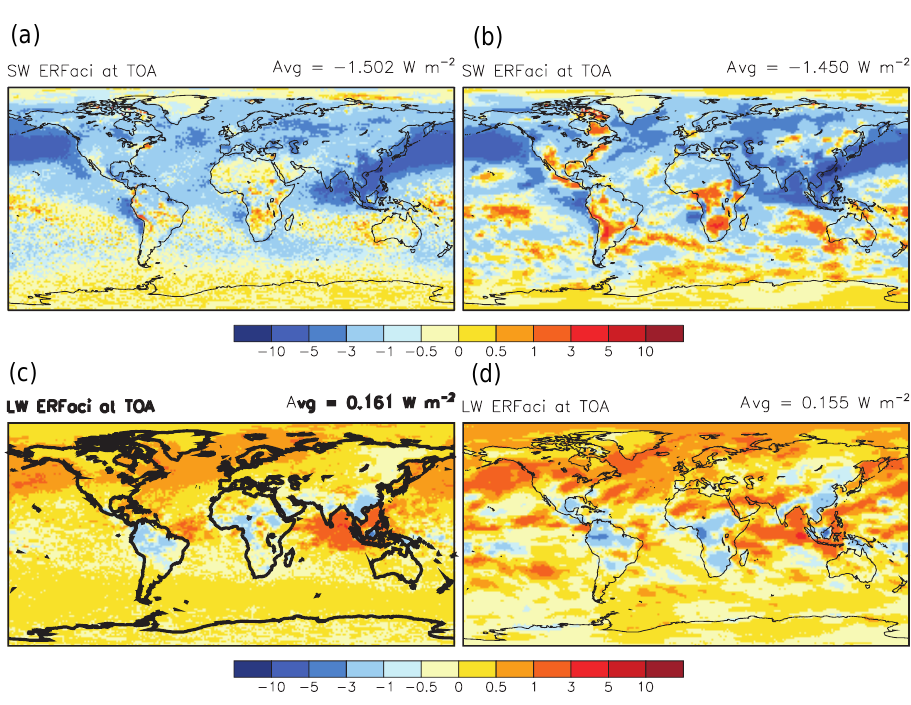
Figure 10. Shortwave (SW, a and b ) and longwave (LW, c and d ) ERFaci at the top of the atmosphere (TOA) for the simulations NUDGE_PD–NUDGE_PI ( a and c ) and AMIP_PD–AMIP_PI ( b and d ). Note that the semi-direct effect is embedded here in the ERFaci term, which corresponds to the “cloud radiative forcing” component in Ghan